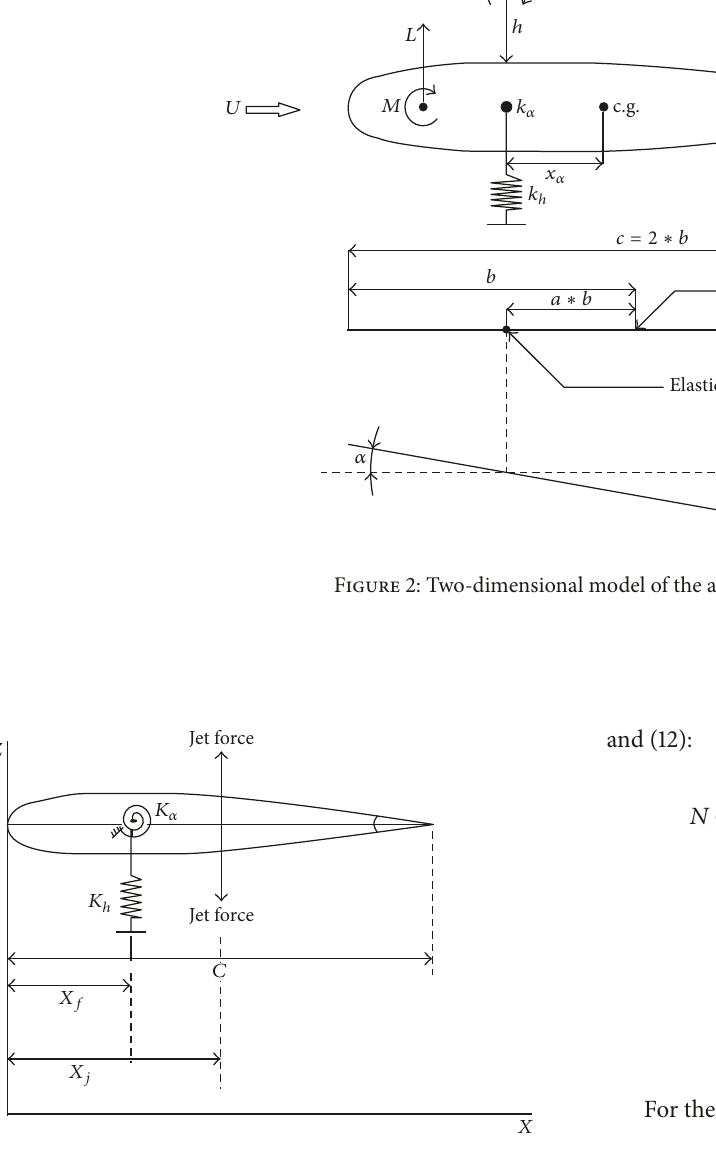
Figure 3: Two-dimensional model of an airplane wing, equipped with an actuator capable of on-off operation (positive direction is